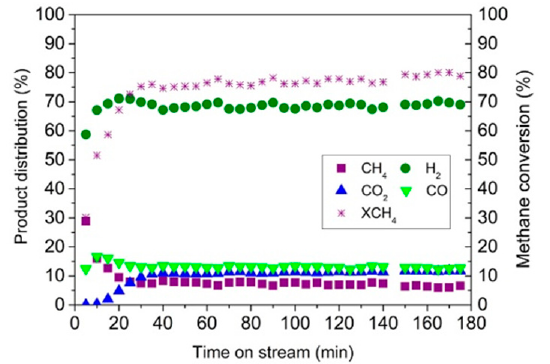
Figure 14. Methane conversion of Ni 60 Co 30 catalyst [16].